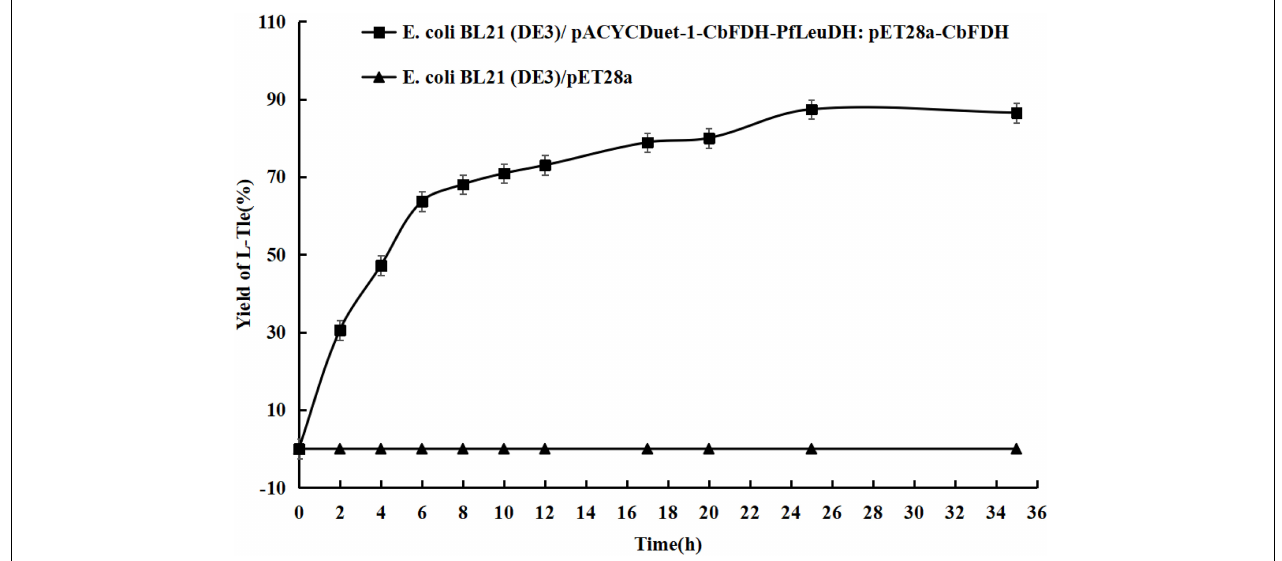
FIGURE 6 | The conversion curves of TMP catalyzed by engineered E. coli strains. Fed-batch feeding strategy was adopted to transform 100 mM of TMP. Without adding coenzyme, the 10-ml reaction system contains 100 mM trimethylpyruvate, 200 mM sodium formate, 500 mM NH 4 Cl-NH 3 · H 2 O buffer, and 0.1 g freeze-dried recombinant bacterial powder. The reaction is at 30 ◦ C and 200 rpm and continued for 35 h.